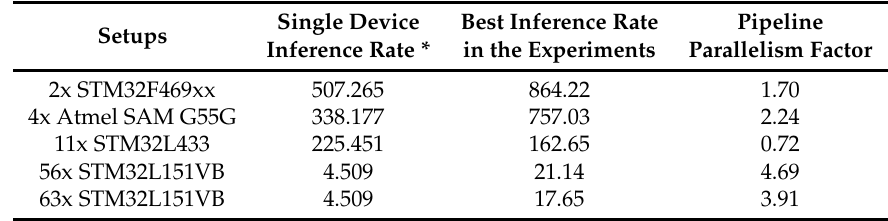
Table 7. Pipeline parallelism factor for each experiment